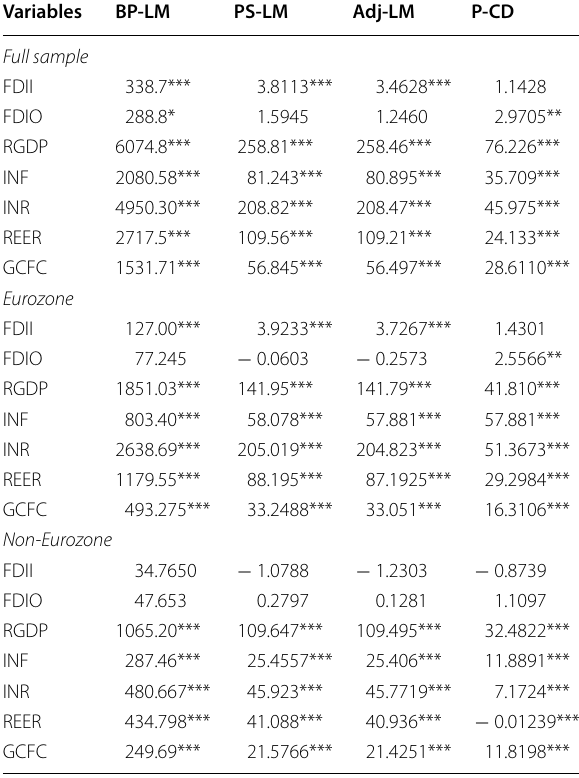
BP-LM, PS-LM, Adj-LM, and P-CD, respectively, denote Breusch-Pagan LM, Pesaran scaled LM, adjusted scaled LM, and the Pesaran CD. ***, **, and * denote significance at 1%, 5%, and 10%